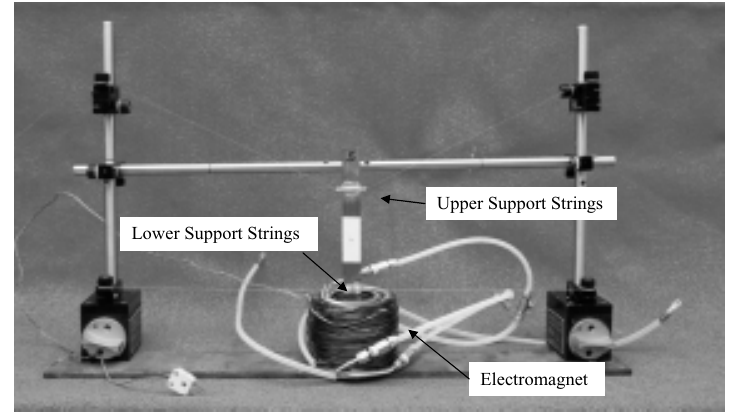
Fig. 1. Beam support